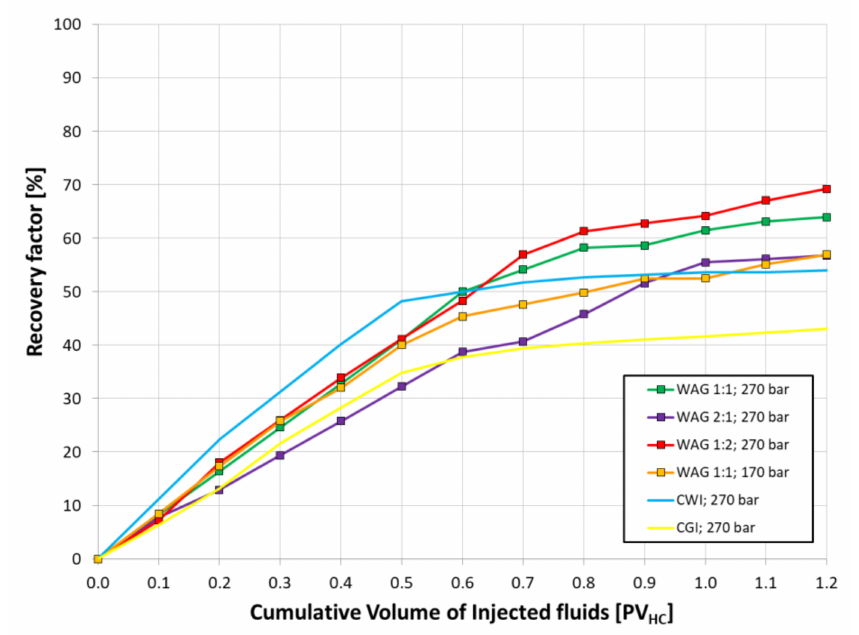
Figure 12. Oil recovery efficiency using MG with different WAG schemes compared to CWI and CGI